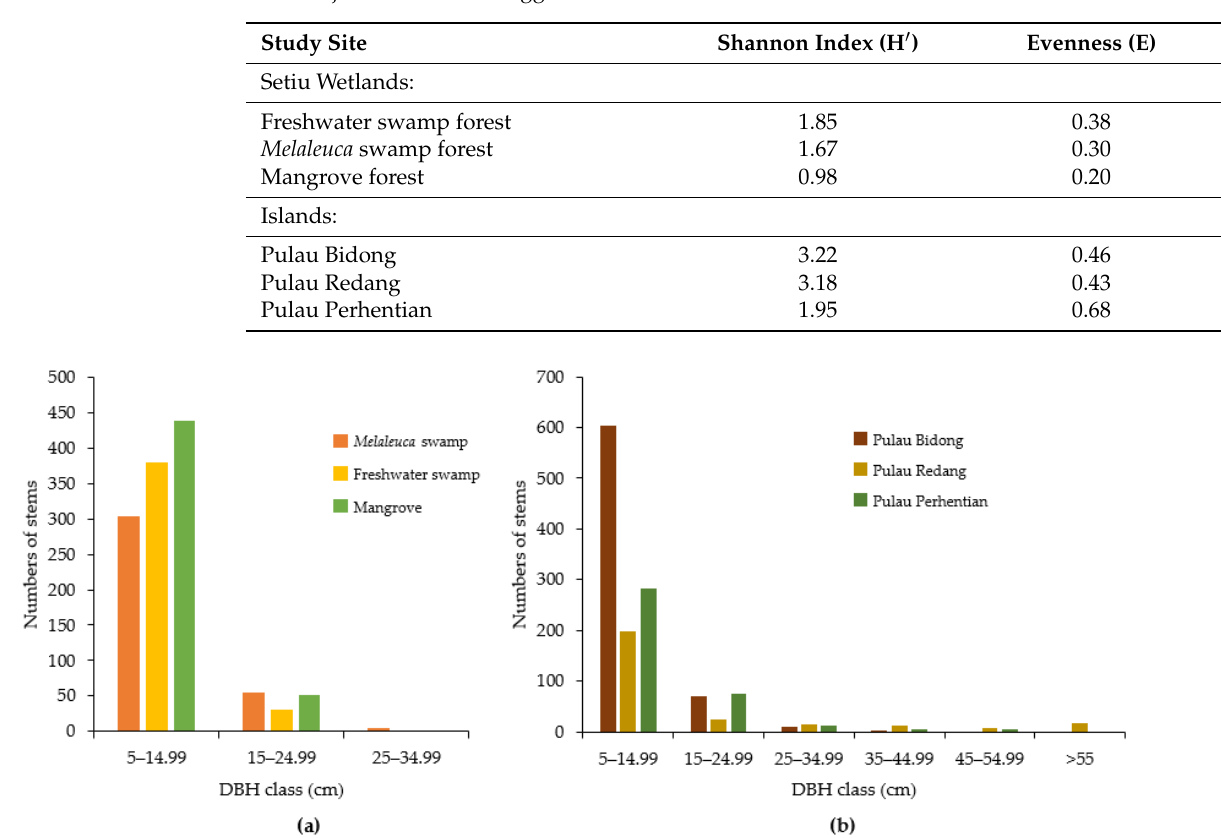
Table 3. The Shannon–Wiener Diversity Index (H (cid:48) ) and species evenness (E) in Setiu Wetlands and three major islands of Terengganu.